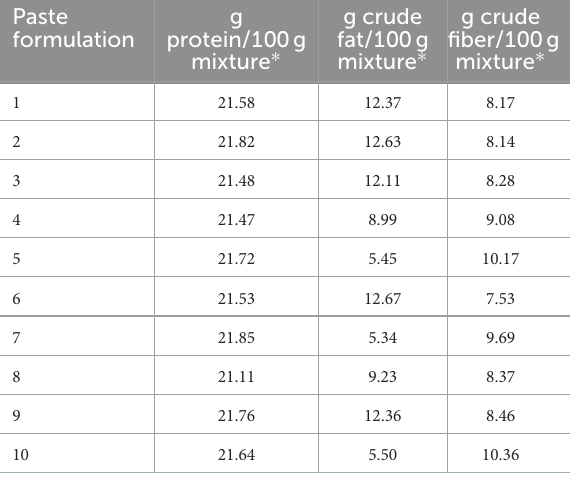
TABLE 2 Protein and lipid composition of each of the formulated